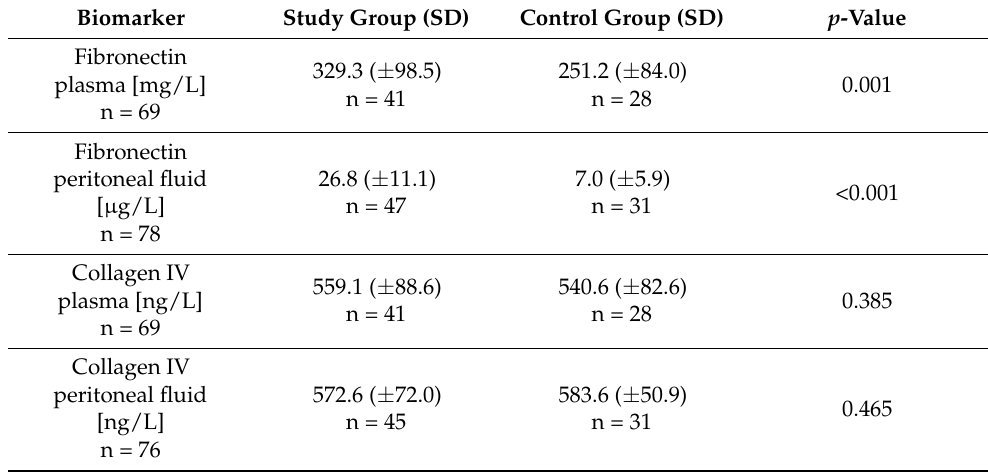
Table 2. Plasma and peritoneal fluid concentrations of fibronectin and collagen IV. SD—standard deviation.